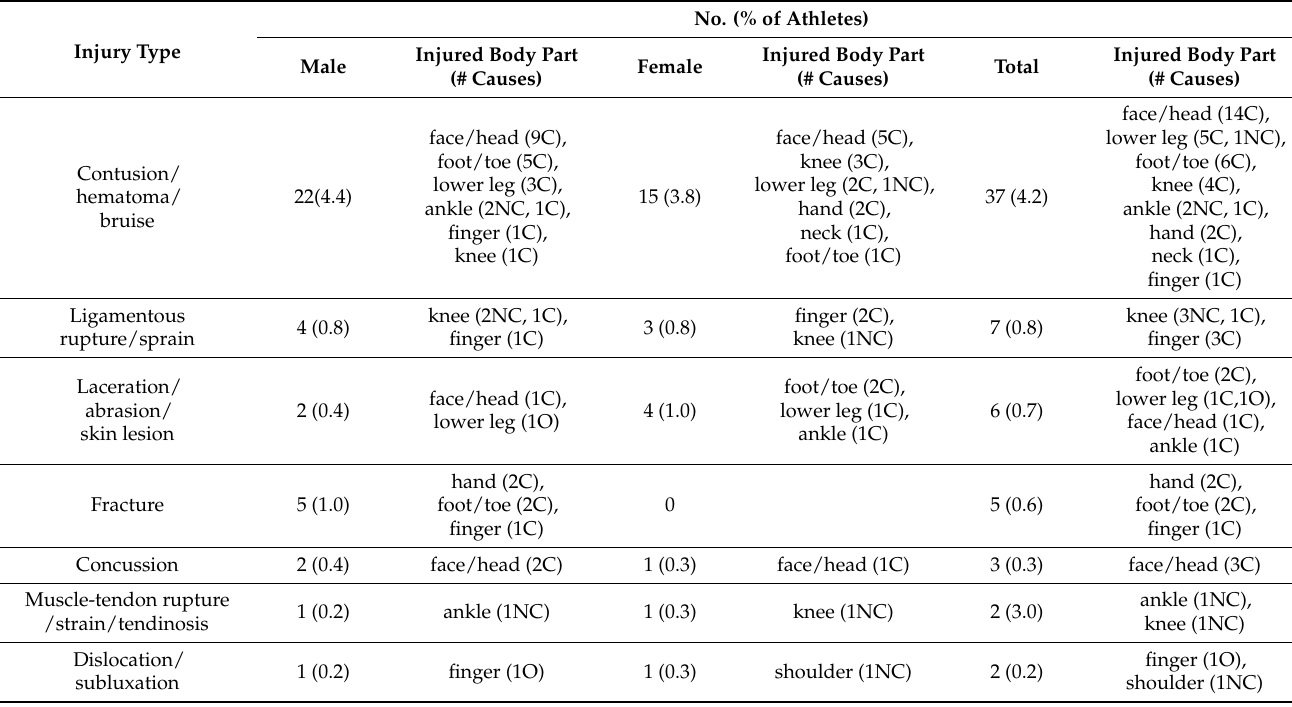
Table 5. Injured body parts according to the cause and location of the